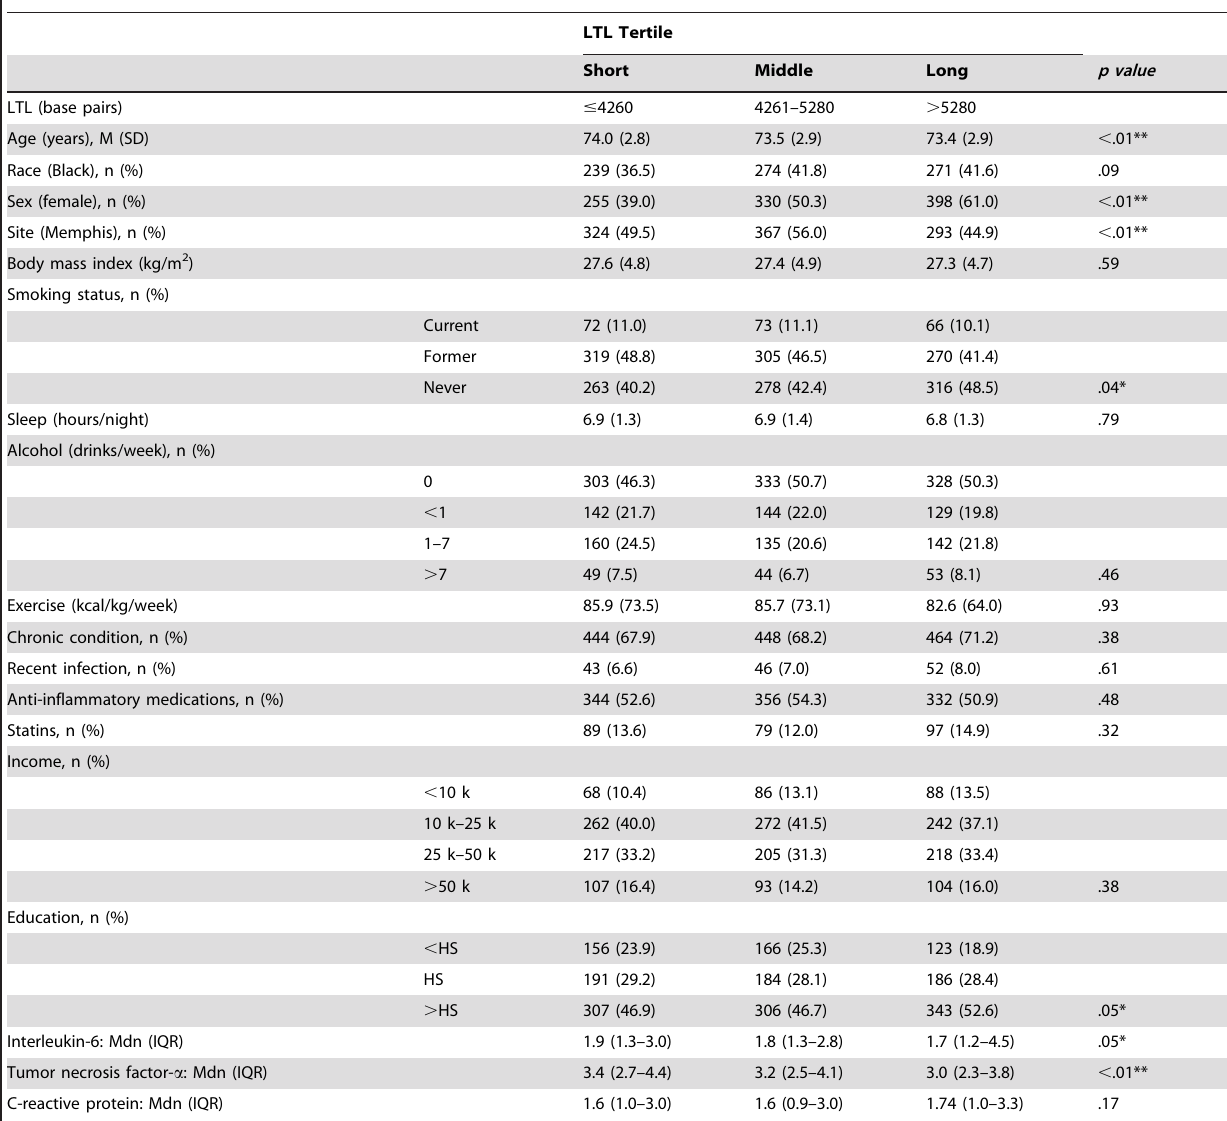
Table 1. Sample characteristics by leukocyte telomere length (LTL)